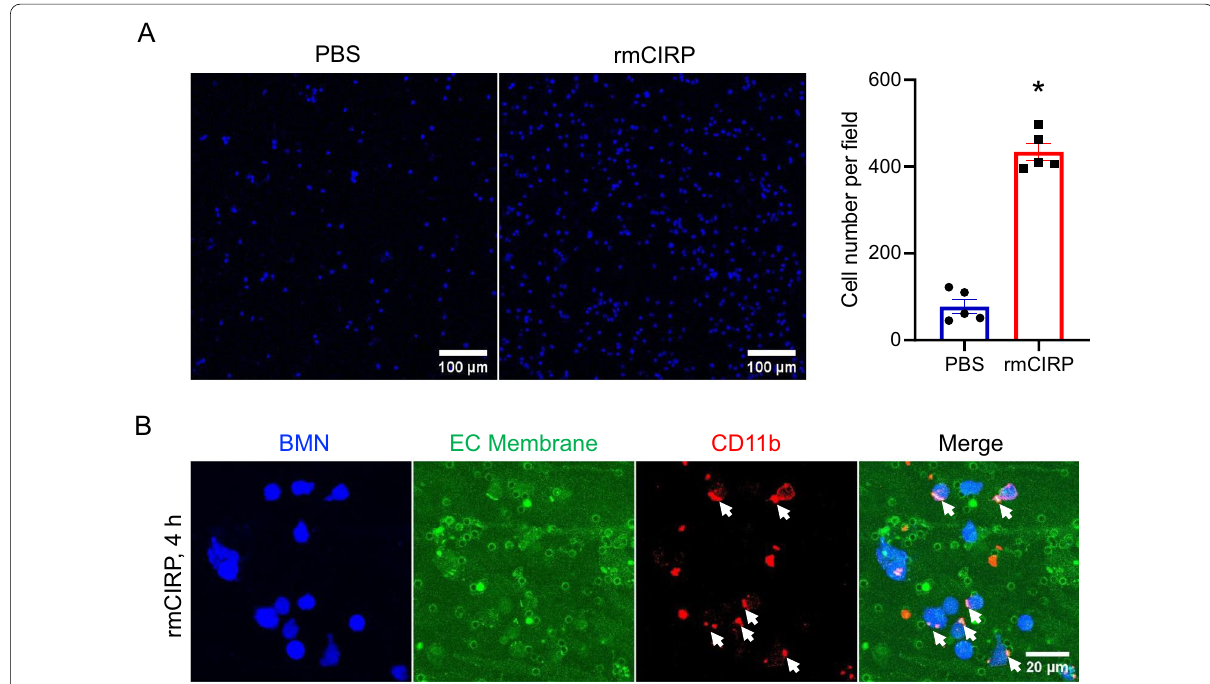
Fig. 4 eCIRP increases the adhesion of neutrophils to endothelial cells. A Neutrophils on the transwell membrane recovered from the TEM assay were counted by using wide field microscopic images and fiji ImageJ. Scale bar, 100 µm. The cell number of neutrophils per field in PBS or eCIRP treated transwell membrane were quantified. Data represented as mean SEM. * p < 0.05, unpaired, two-tailed student’s t -test. B Representative ± images of neutrophil adhesion to the endothelial cells showing CD11b on the neutrophils (red color) co-localized with plasma membrane staining signal of the endothelial cells (green color) on the transwell membrane after TEM assay. The arrows in the CD11b and the merge panels indicate polarization of CD11b with the plasma membrane staining on the neutrophils. Scale bar, 20